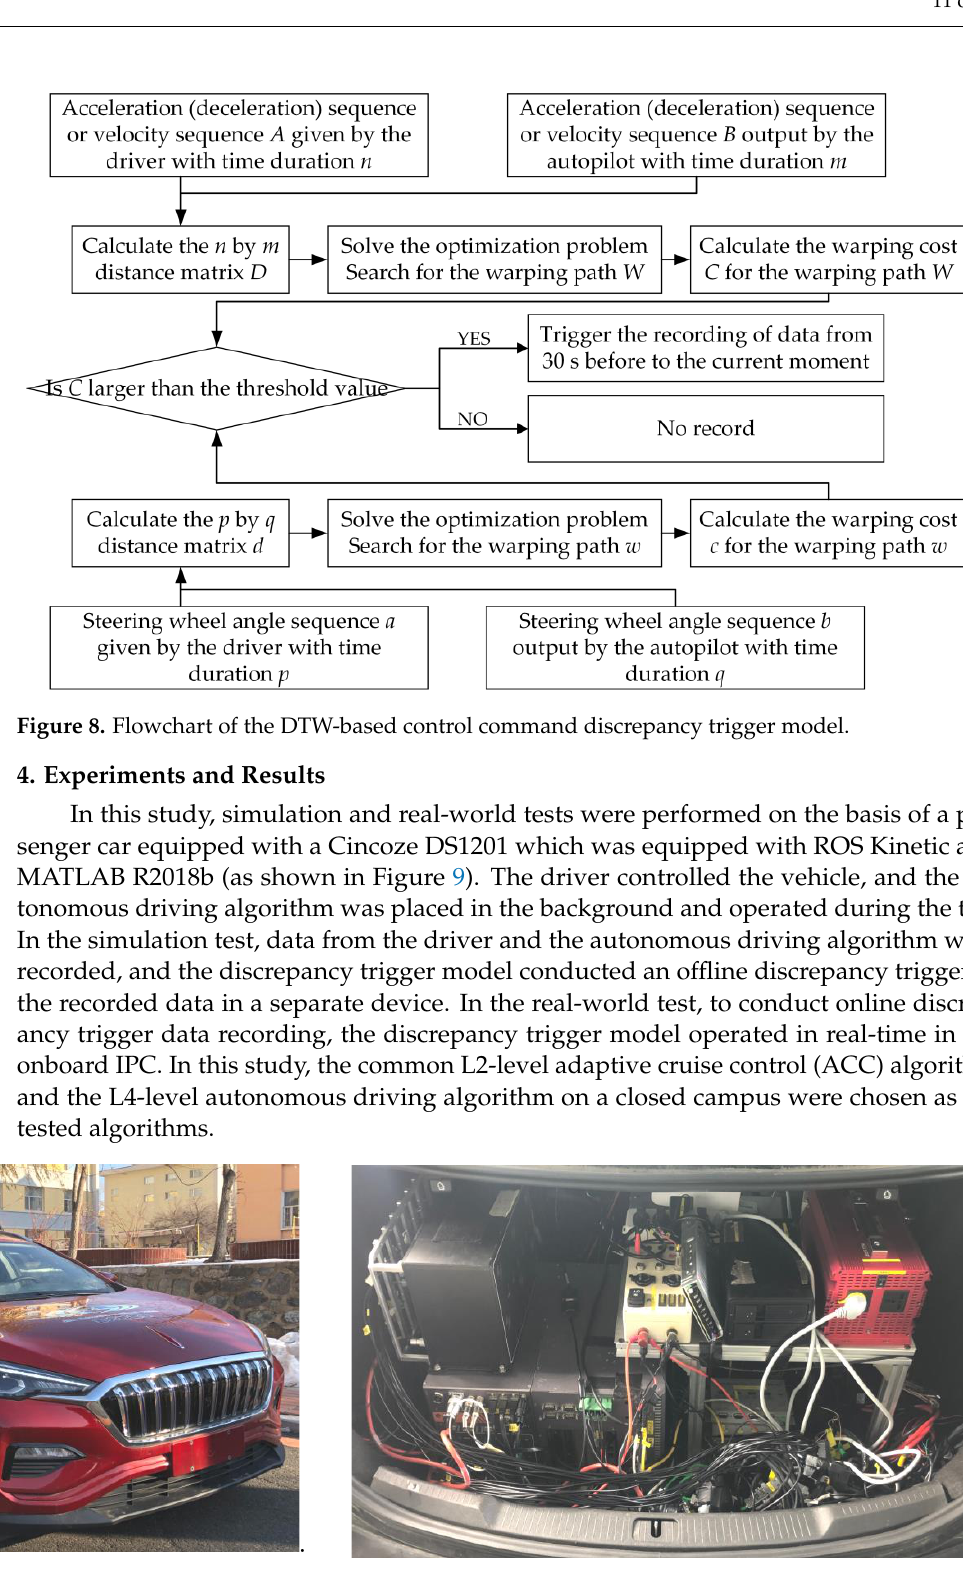
Figure 9. The real vehicle test platform.